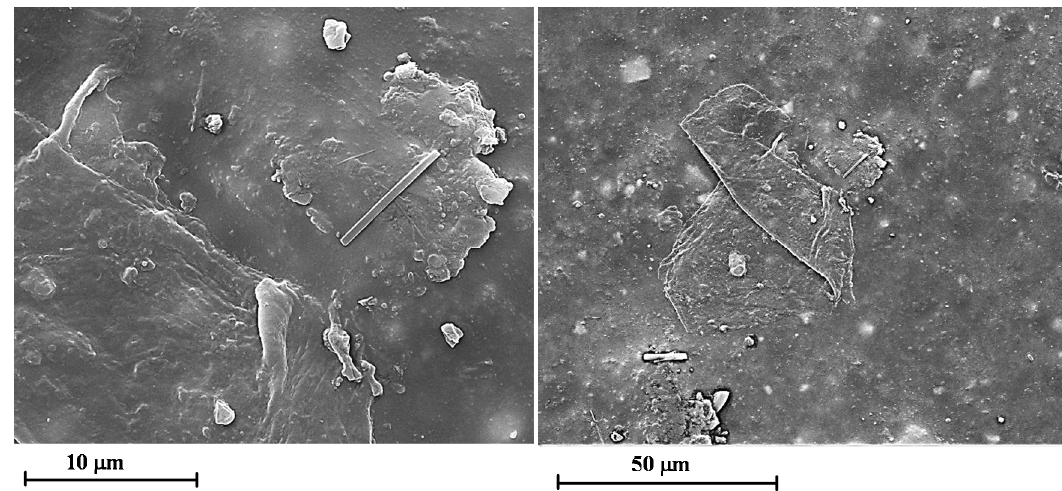
Figure 7. SEM micrographs of the film loaded with 0.1 wt.% of GNPs before UV irradiance (01GNPs sample) at different magnifications.